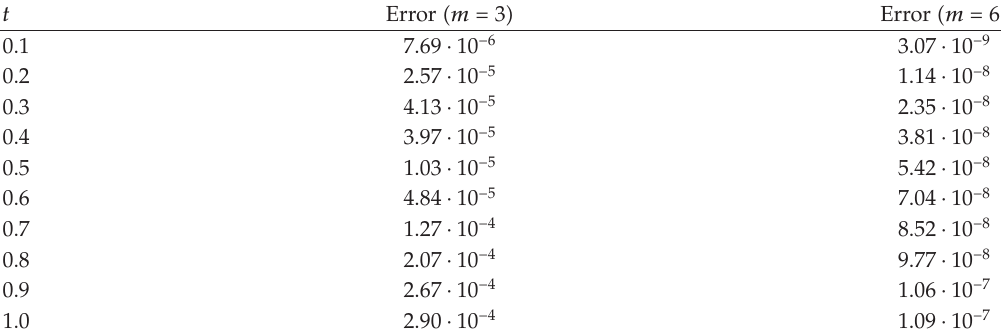
Table 3: Problem (cid:4) 5.4 (cid:5) —Example